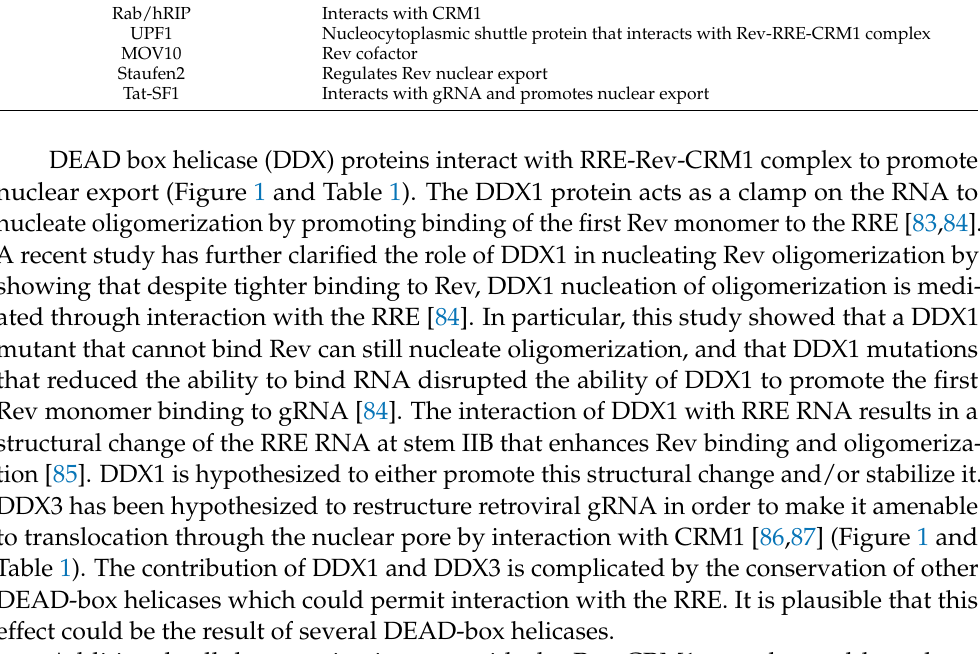
Table 1. Summary of cellular proteins involved in export of retroviral gRNA from the nucleus. Protein Function in gRNA Nuclear Export CRM1 Major nuclear export receptor Ran G protein, Ran GTP hydrolysis cycle drives export of CRM1 complex DDX1 Nucleates Rev oligomerization on RRE DDX3 Restructures gRNA for translocation through NPC Nup62, Nup98, Nup124, Nup153 Nucleoporins that have been identified as part of the NPC involved in gRNA nuclear export PACS1 Nucleocytoplasmic shuttle protein that interacts with Rev-RRE-CRM1 complex ANP32A/B Mediate export of viral RNAs via interaction with Rev-RRE-CRM1 complex eIF5a Mediates Rev-RRE-CRM1 interaction with NPC Rab/hRIP Interacts with CRM1 UPF1 Rev cofactor Staufen2 Regulates Rev nuclear export Tat-SF1 Interacts with gRNA and promotes nuclear